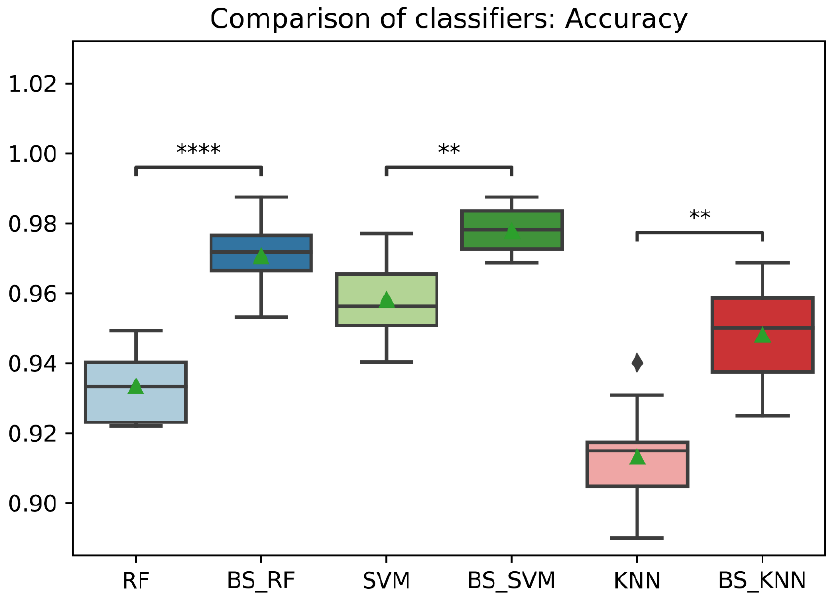
Figure 9. Comparison of accuracy between classification models with imbalanced and oversampled data. RF = Random Forest; BS_RF = Borderline-SMOTE Random Forest; SVM = Support Vector Machine; BS_SVM = Borderline-SMOTE Support Vector Machine; KNN = K-nearest Neighbors; BS_KNN = Borderline-SMOTE K-nearest Neighbors; **: p ≤ 0.01; ****: p ≤ 0.0001.